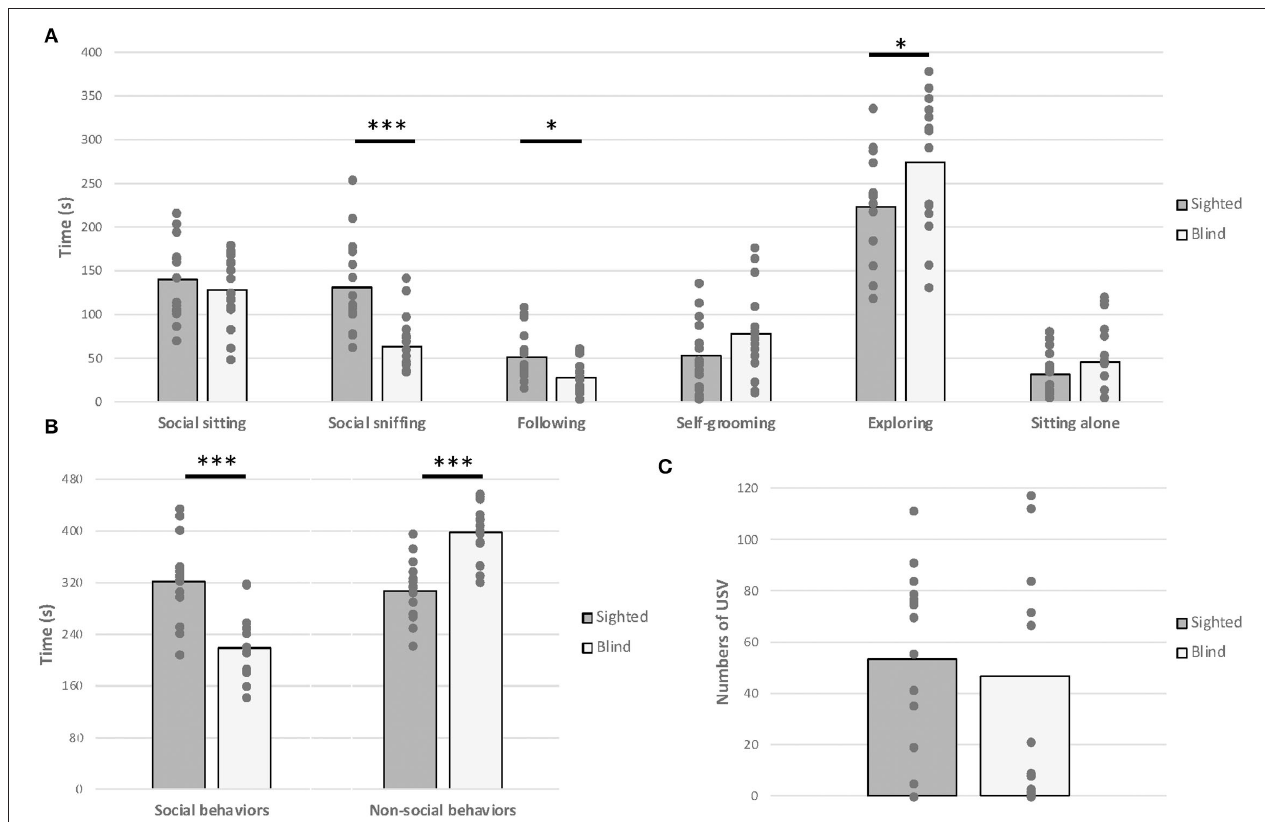
FIGURE 5 | Juvenile social test. Anophthalmic and sighted mice assayed to a 10-min juvenile social test at PND 30–35: (A) Mean ( ± SE) of the time spent (s) displaying social behaviors, such as social sitting, social sniffing, following the congener, and non-social behaviors, such as exploring, sitting alone, and self-grooming. (B) Mean ( ± SE) of the time spent (s) displaying social behaviors and non-social behaviors. (C) Mean ( ± SE) of total number of USV calls produced (* p < 0.05; *** p <